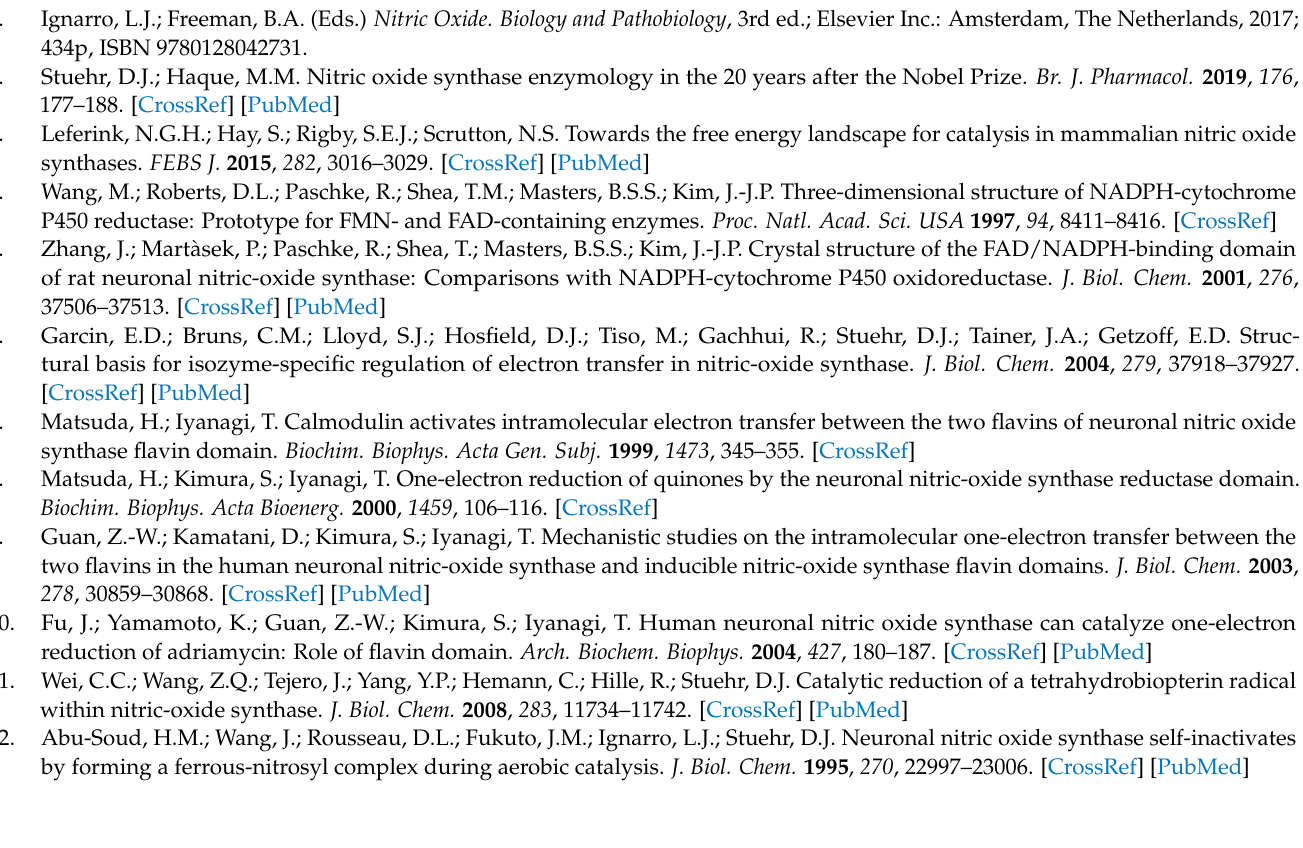
(Table A1) and the data of Figure 1B, we obtain R p = 2.8 Å (log k 11 = 4.4), and R p = 3.1 Å (log k 11 = 4.0),